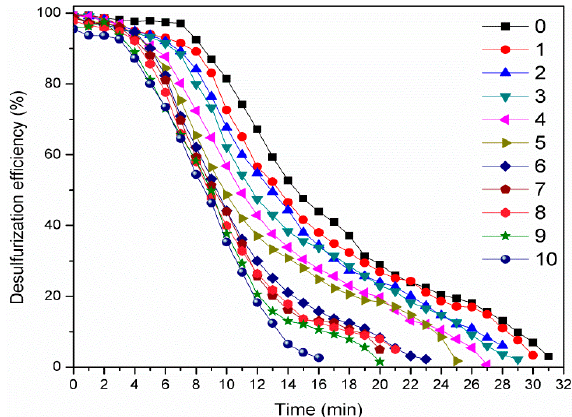
Figure 7. SO 2 desulfurization efficiency of the regenerated adsorbents, where 0–10 stands for number of cycles.